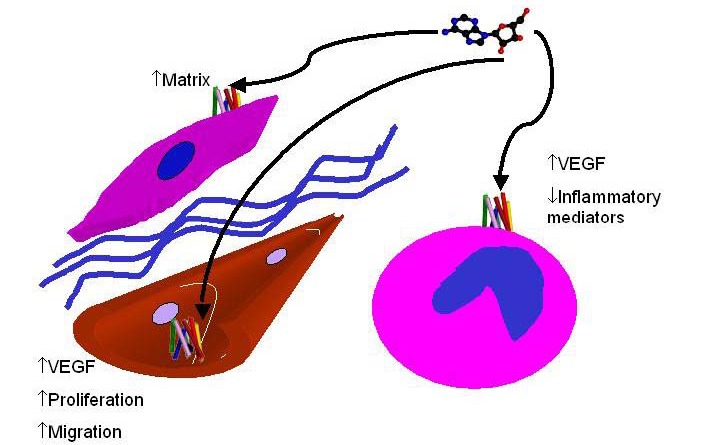
FIGURE. The effect of adenosine, acting at A 2A receptors, on the cells involved in wound healing. VEGF: vascular endothelial cell growth